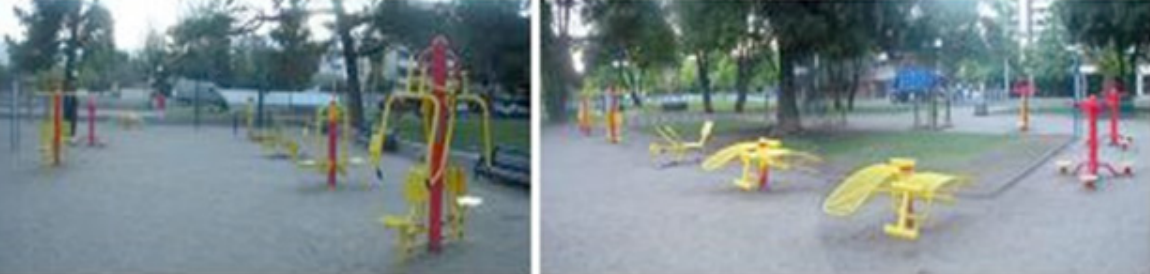
Figure 1: Outdoor gym in Santiago. Source: own elaboration